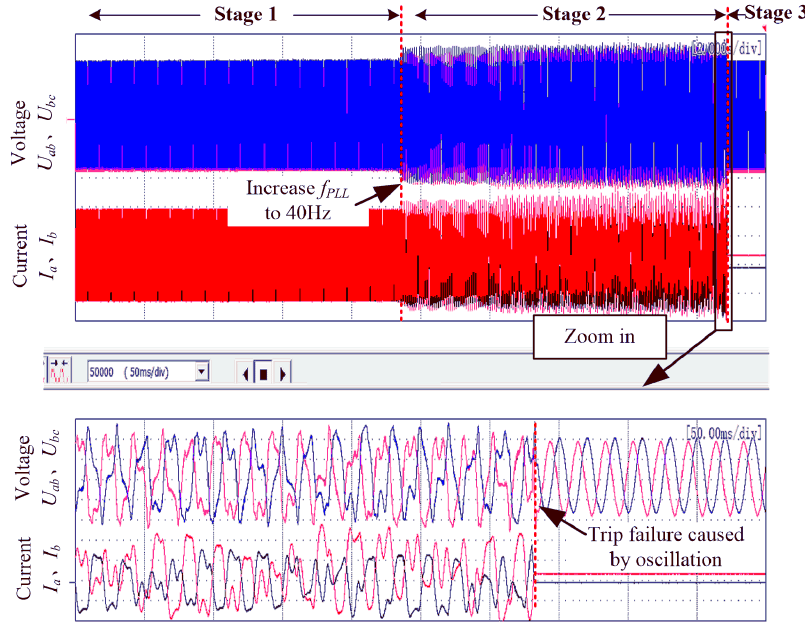
Figure 10. The experimental results of a grid-connected VSC with changing PLL bandwidth (Time: 50 ms/div, AC voltage: 500 V/div, AC current: 25 A/div).